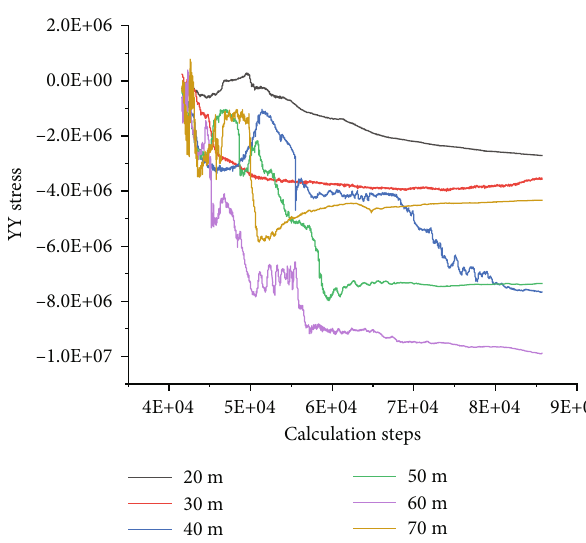
Figure 20: Stress changes of end face roof under di ff erent calculation